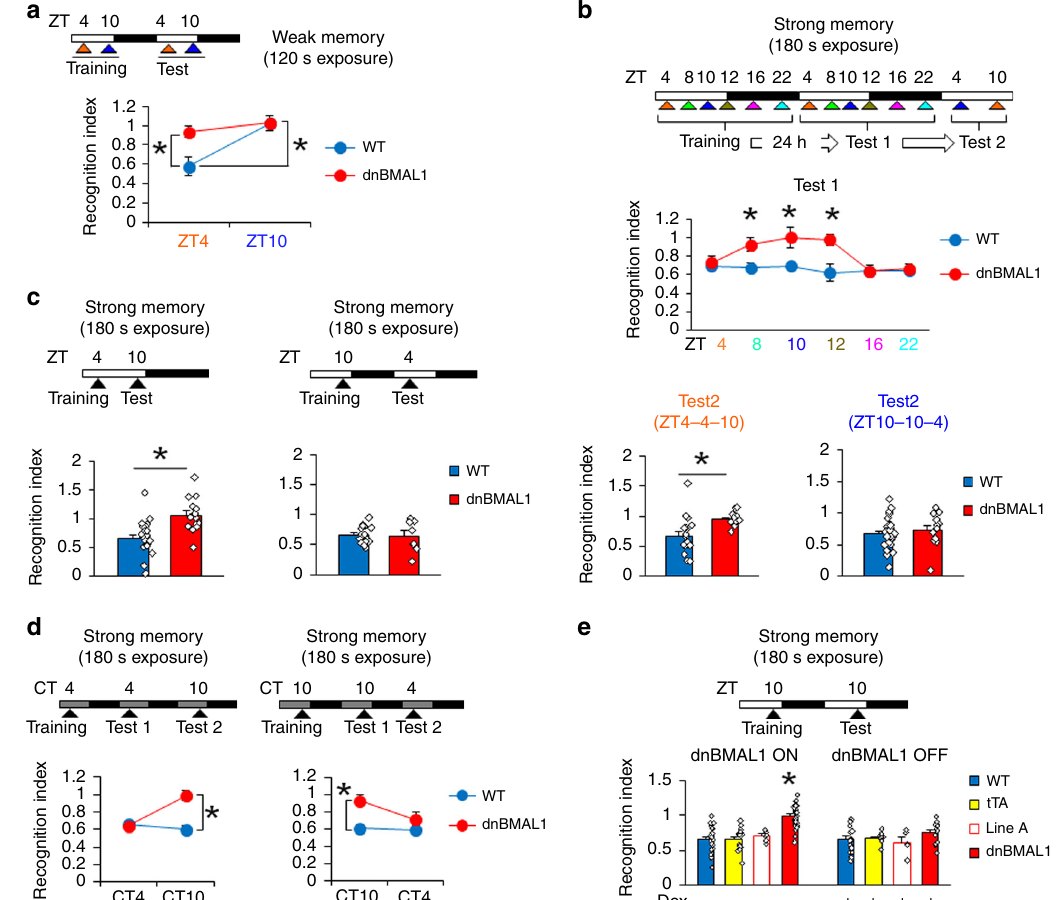
Fig. 3 Impaired retrieval of social recognition memory in dnBMAL1 mice from ZT8 to ZT12 following strong training. Experimental designs are illustrated at the top of each panel. a Impaired memory both at ZT4 and ZT10 in dnBMAL1 mice but only at ZT10 in WT mice, following weak training at ZT4 or ZT10, respectively. b Separate groups are trained at ZT4, ZT8, ZT10, ZT12, ZT16, or ZT22 and tested 24 h later. (Upper) Retrieval at Test 1. Impaired retrieval in dnBMAL1 mice at ZT8 – 12. (Lower) Mice that are initially tested at ZT4 or are re-tested at ZT10 or ZT4, respectively. Impaired retrieval in dnBMAL1 mice re-tested at ZT10. * p < 0.05, compared to WT mice at each time point. c Retrieval impairment at ZT10 but not at ZT4 in dnBMAL1 mice trained at ZT4 or ZT10 and then tested at ZT10 or ZT4, respectively. d Under DD, impaired retrieval in dnBMAL1 mice at CT10. e Retrieval impairment depends on dnBMAL1 expression (not observed in dnBMAL1 OFF and single transgenic mice). dnBMAL1 ON mice display signi fi cantly worse recognition indexes compared to the control groups. * p < 0.05, compared to the other control groups. All values are mean ± SEM. Individual data points are displayed as dots. * p < 0.05 as determined by two-way ( a , b , d , e ) or one-way ( c ) ANOVA with post hoc test. The results of the statistical analyses are presented in Supplementary Table 2. Source data are provided as a source data fi